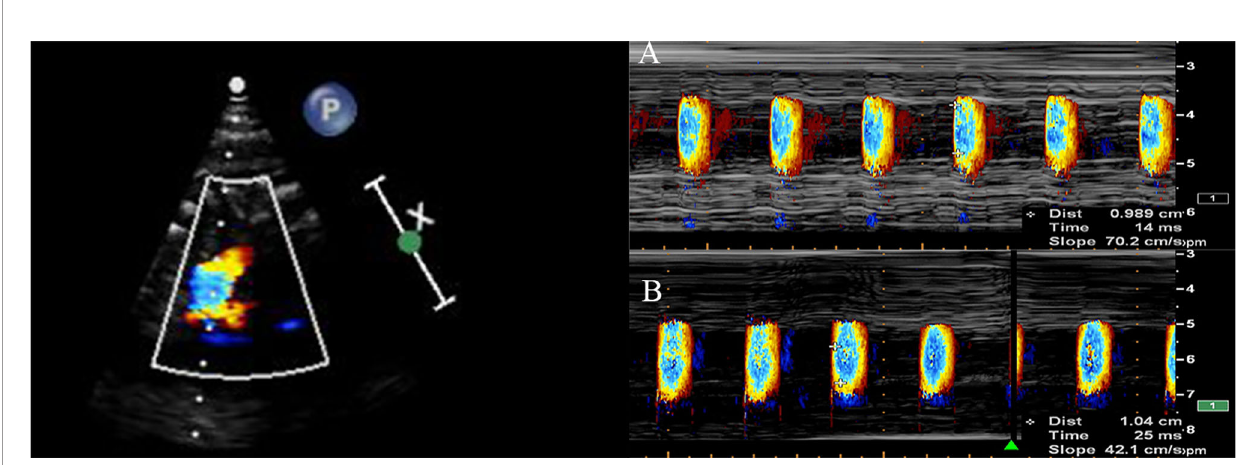
FIGURE 1 | The aortic propagation velocity evaluated by color M-mode echocardiography display across the aorta arch from the sagittal view in a normal fetus (A) and in a fetus exposed to GDM (B)